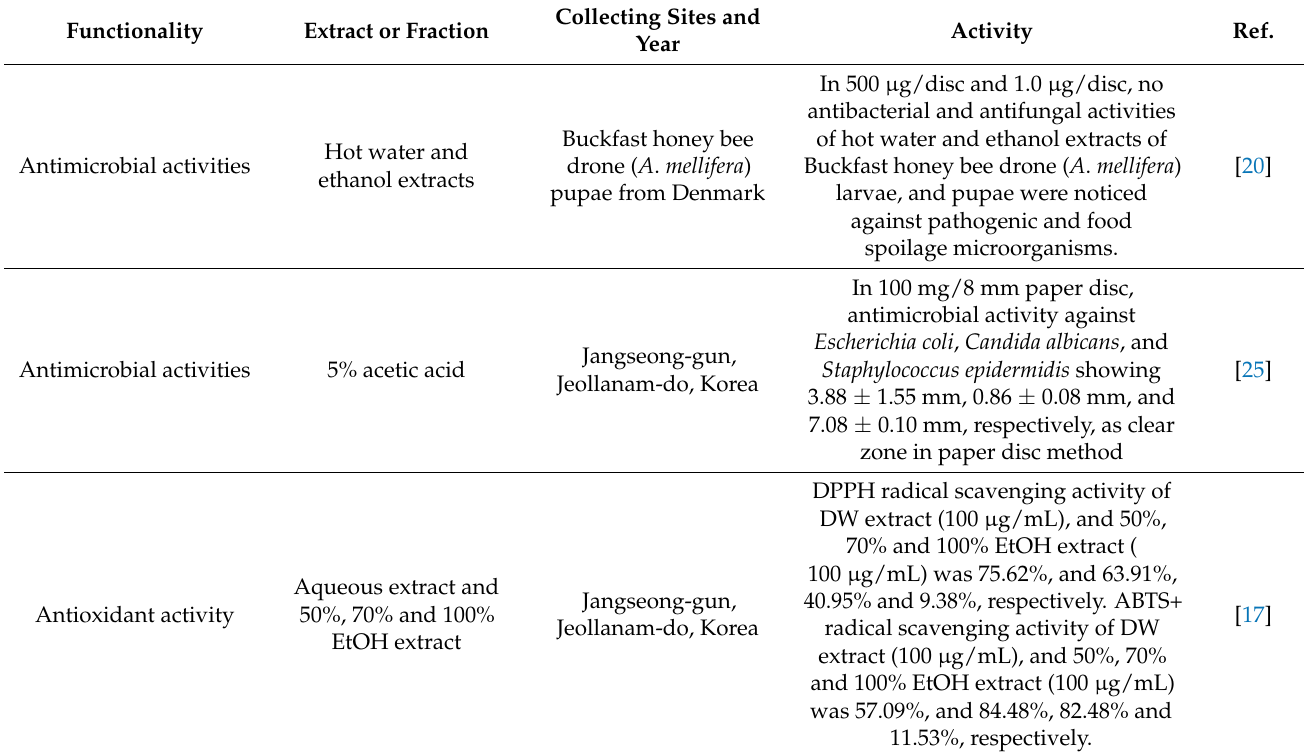
Table 3. Health functional effects of honeybee ( Apis mellifera L.) drone